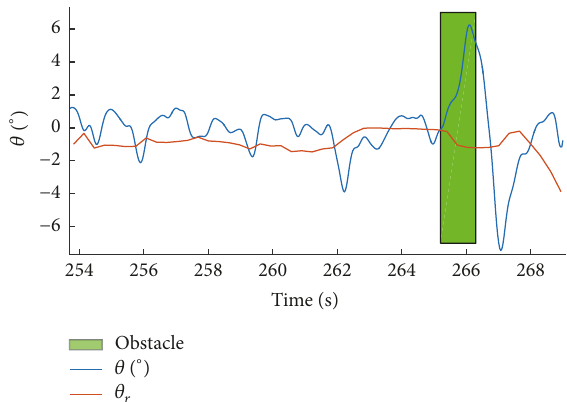
Figure 30: Partial ground effect test with the multirotor in